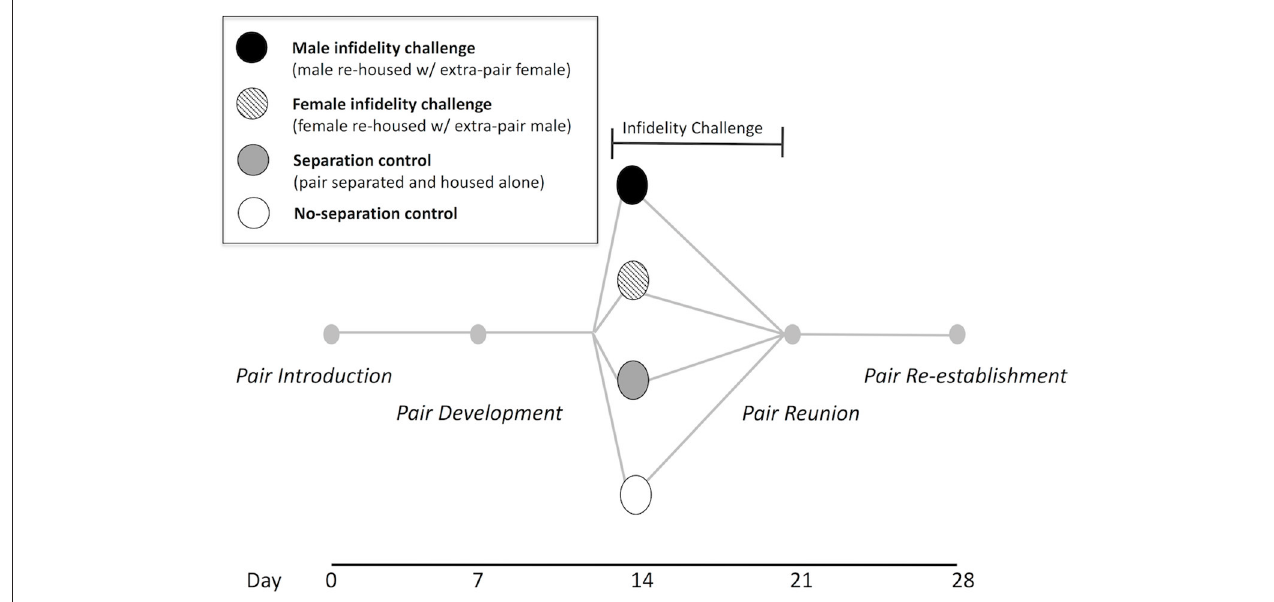
FIGURE 1 | Experimental timeline. Trials of 5-min dyadic (male + female) social interactions and USVs were assessed once per week. Trials consisted of intra-pair interactions at day 0, 7, 21, and 28 for all pairs ( N = 44). For the infidelity challenge, pair members were separated from their mate and re-housed with an unfamiliar, opposite-sex individual for 1 week (male infidelity challenge N = 11, female infidelity challenge N = 11), beginning with an extra-pair dyadic interaction on day 14. Control pairs were either separated and housed alone for 1 week ( N = 11) or not separated ( N = 11). Original pairs were assessed again at day 21 and day 28. After day 28, paternal pup retrieval tests were conducted for pairs that produced a